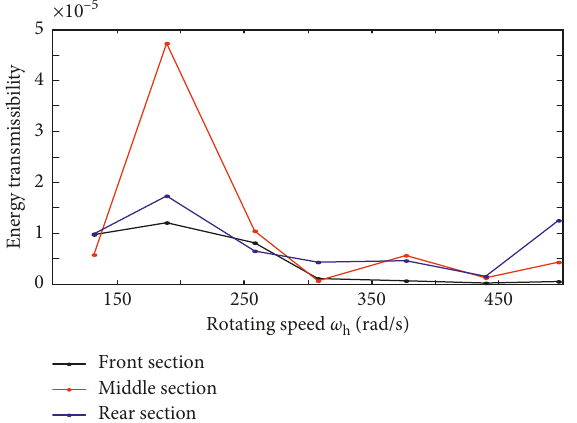
Figure 16: Experimental vibration transmissibility ξ with varying rotating speed of high-pressure rotor ω h : front section (black), middle section (red), and rear section (blue).